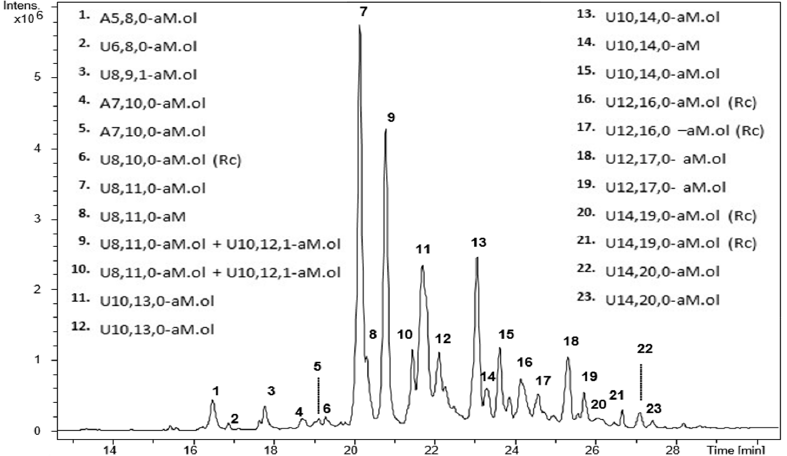
Figure 2. LC-MS profile (BPC) of a representative Fragmin ® sample (Frag-5). Mass signals assignment of the main components is reported. LC conditions: isocratic step at 15% B for 1 min, followed by a linear gradient from 15% to 40% B in 31 min; then, column washing and reconditioning in the initial conditions were performed.